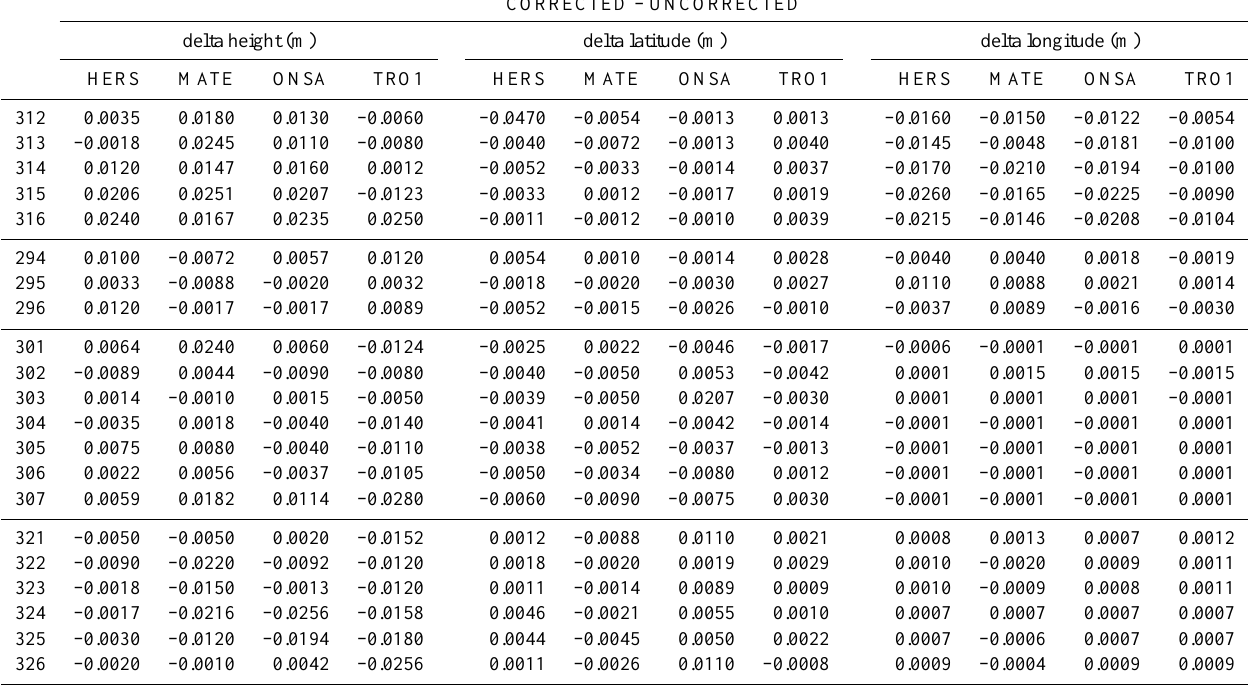
Table 3. Differences in the calculated station coordinates (delta height/latitude/ longitude, in meters) when PPP is performed with the corrected and uncorrected observation files. Positive differences in height, latitude and longitude are upward, northward and eastward,